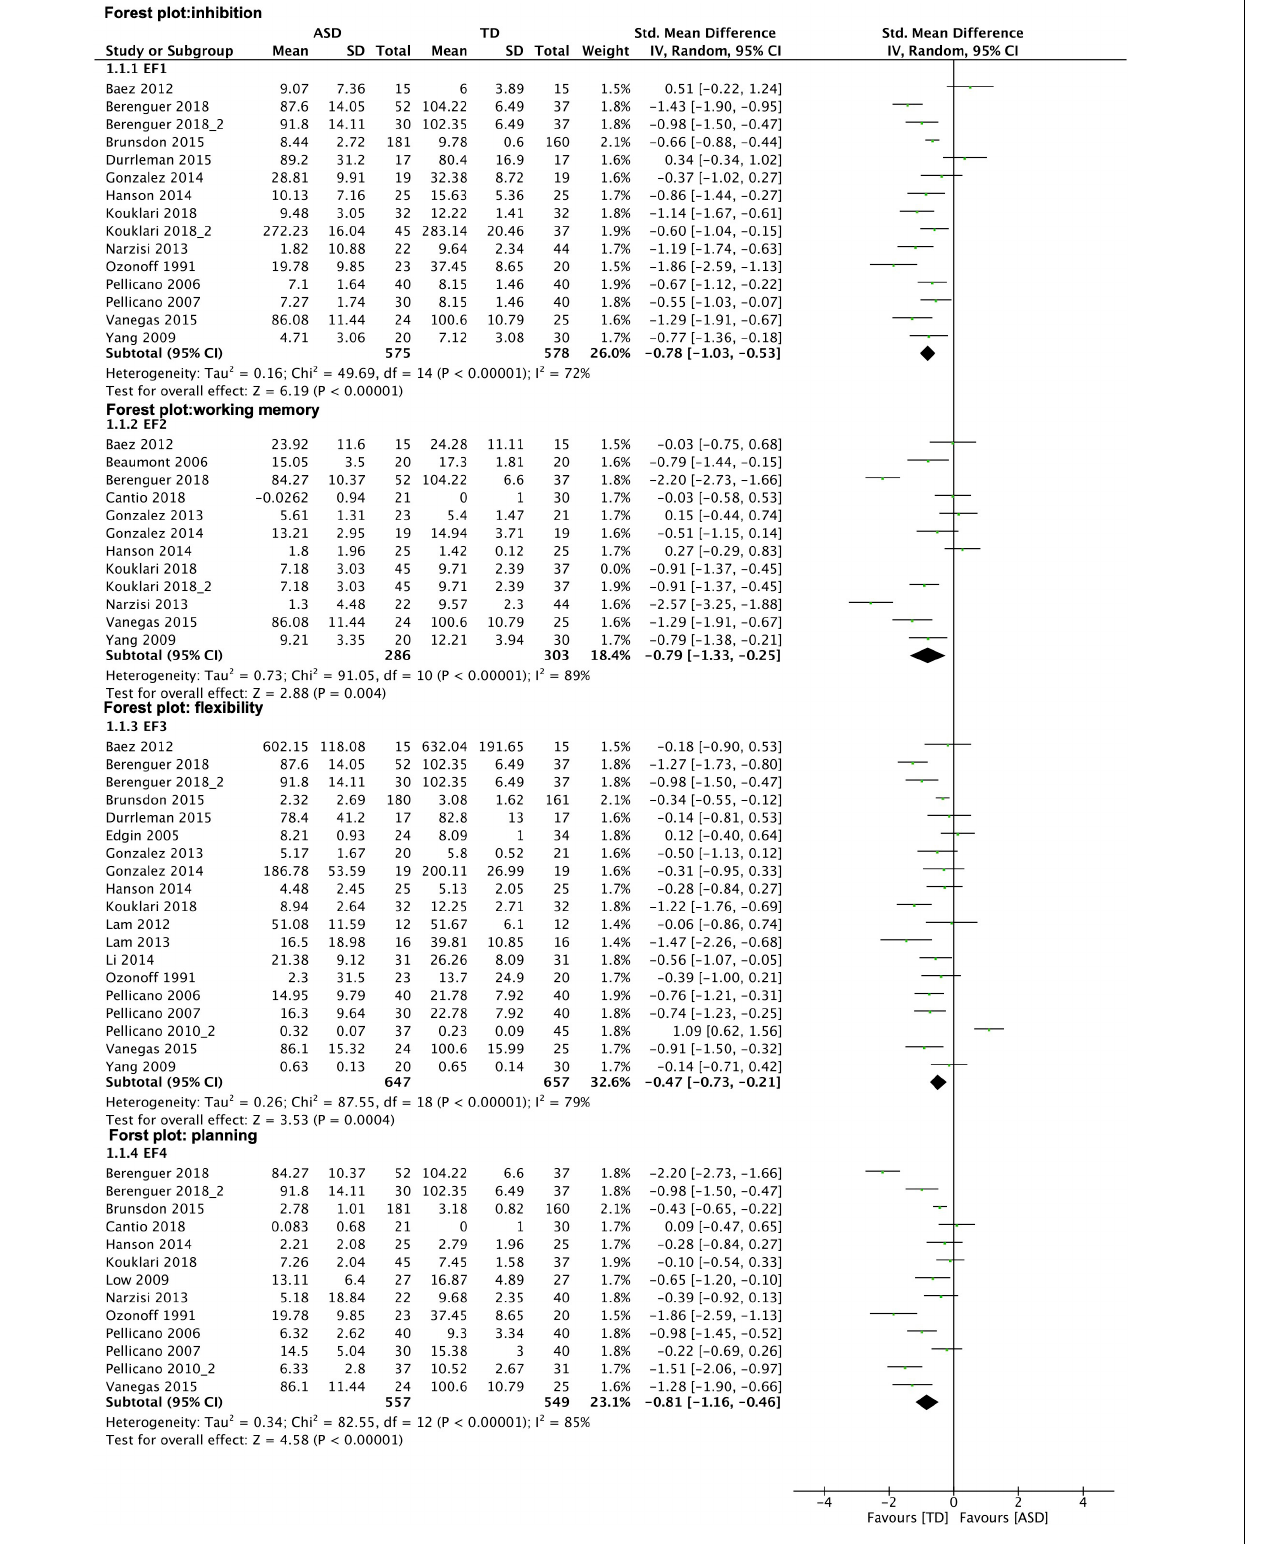
Frontiers in Psychiatry |